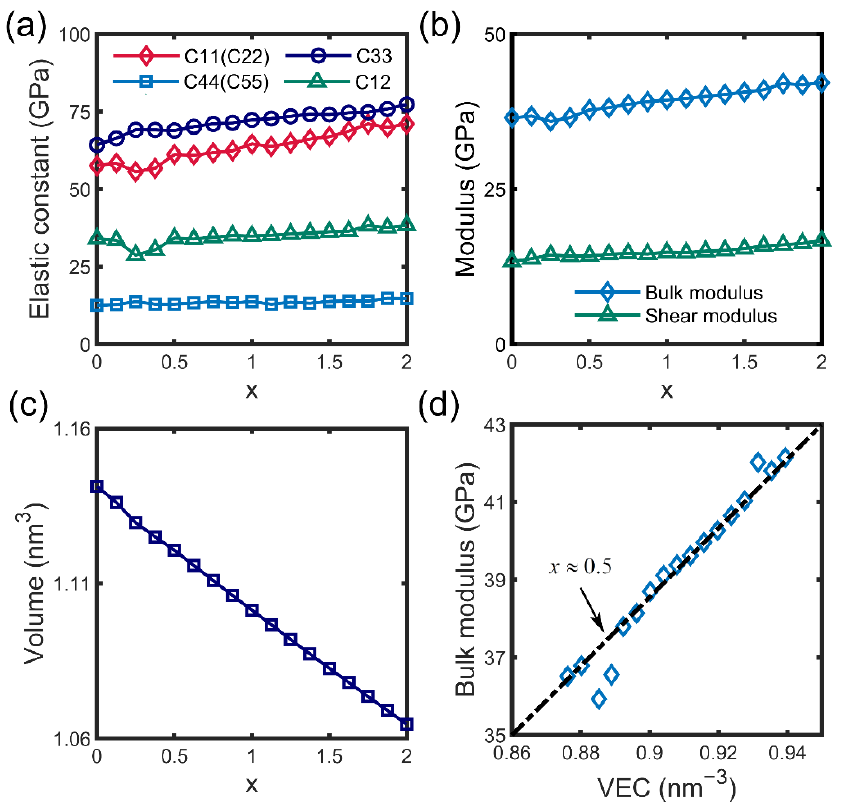
Figure 2. Elastic properties with the increasing of Sb content x. ( a ) The critical elastic constants and ( b ) deduced comprehensive elastic properties of bulk modulus and shear modulus with the change of x from 0 to 2. ( c ) The volume of configuration at each Sb content x which is a presentation of electronic location. ( d ) Linear relation of bulk modulus and the average valence electron concentration (VEC) except for potencies around x ≈ 0.5.